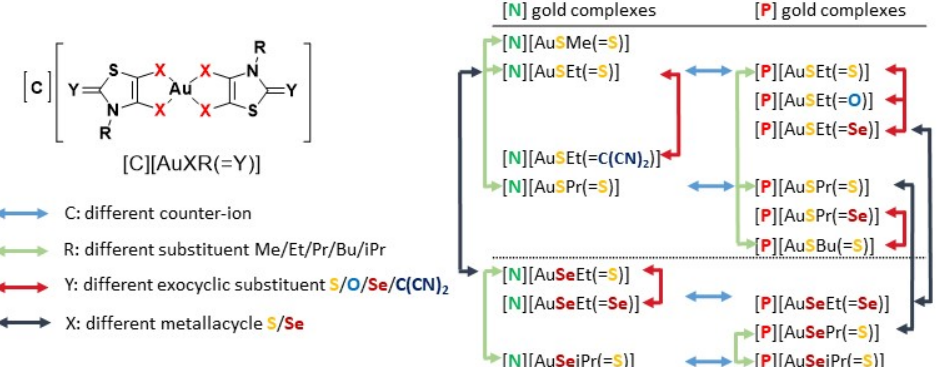
Chart 1. Schematic notation of the Au(III) complexes, [C][AuXR(=Y)], (C = P for Ph 4 P + or N for Et 4 N + , X = S or Se, Y = O, S, Se, C(CN) 2 and R = Me, Et, Pr, i Pr and Bu) and the structure relationships of the series of gold bis(dithiolene/diselenolene) complexes investigated in this